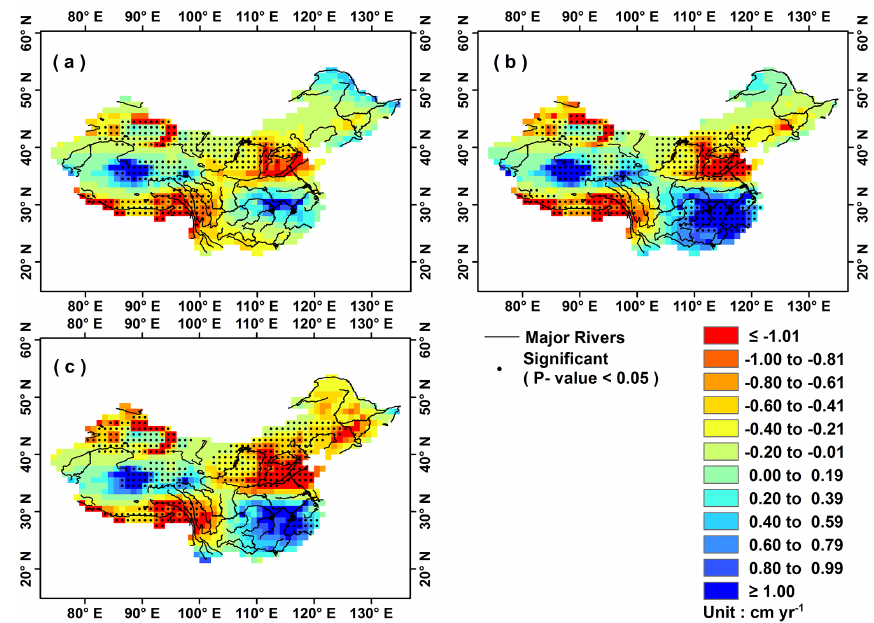
Figure 8. Spatial distribution of trends derived from linear least squares regression for seasonally averaged TWS in 2003–2013 from the scaled GRACE data (unit: cmyr − 1 ); (a) spring (March–May); (b) summer (June–August); (c) autumn (September–November). Grids with trends significant ( F test) at 95% confidence level are marked by black